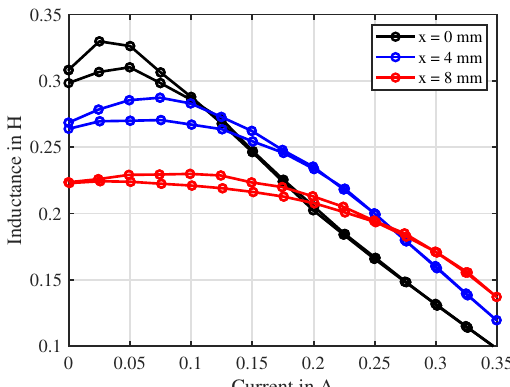
Figure 15. Identified inductance variation over changing current at three different fixed positions. The dependency is strongly hysteretic.